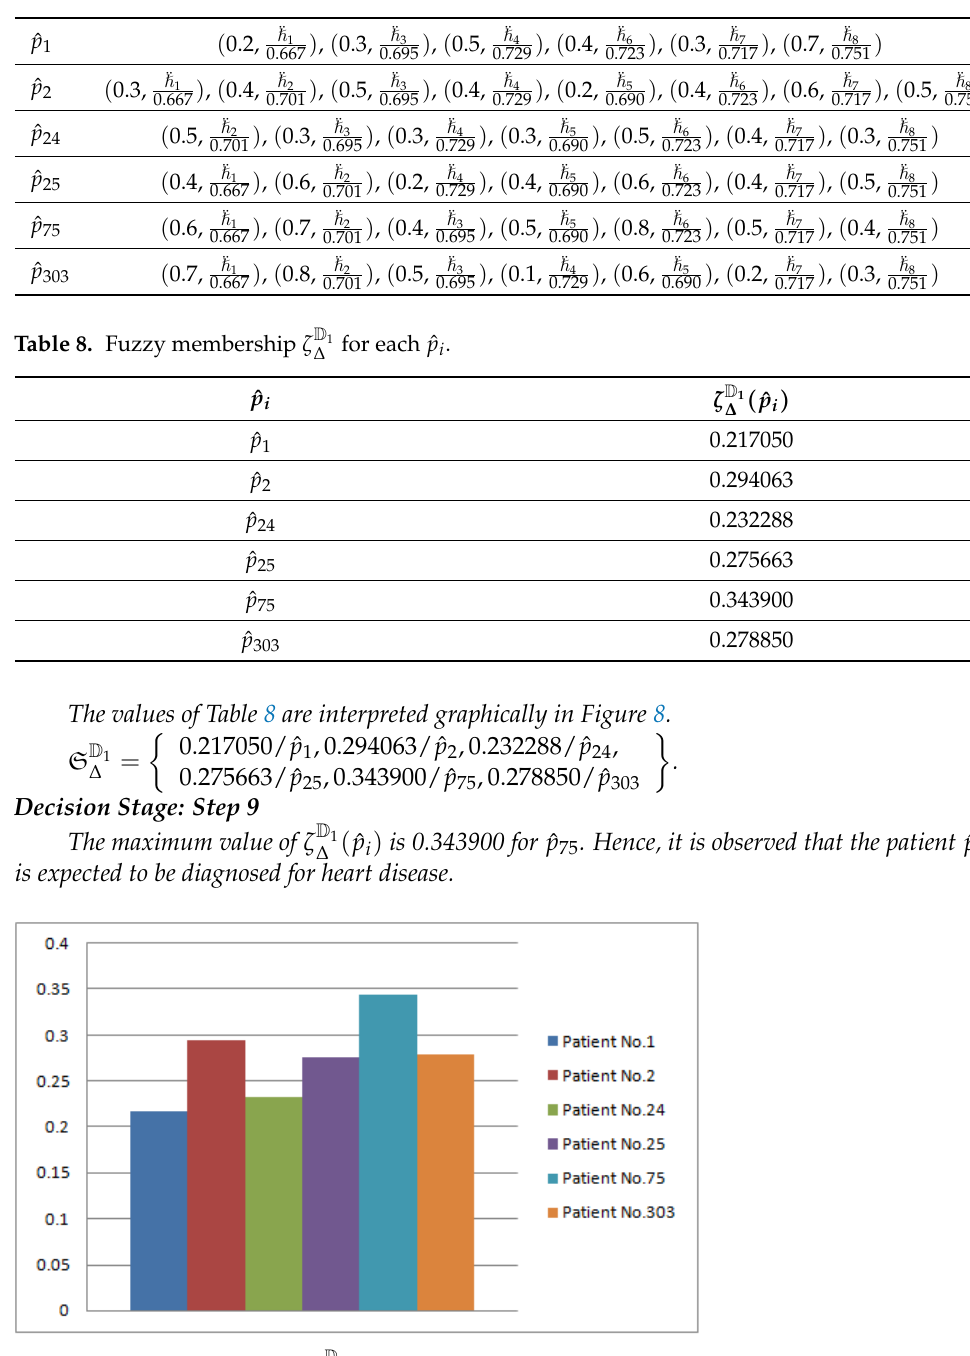
Figure 8. Fuzzy membership ζ